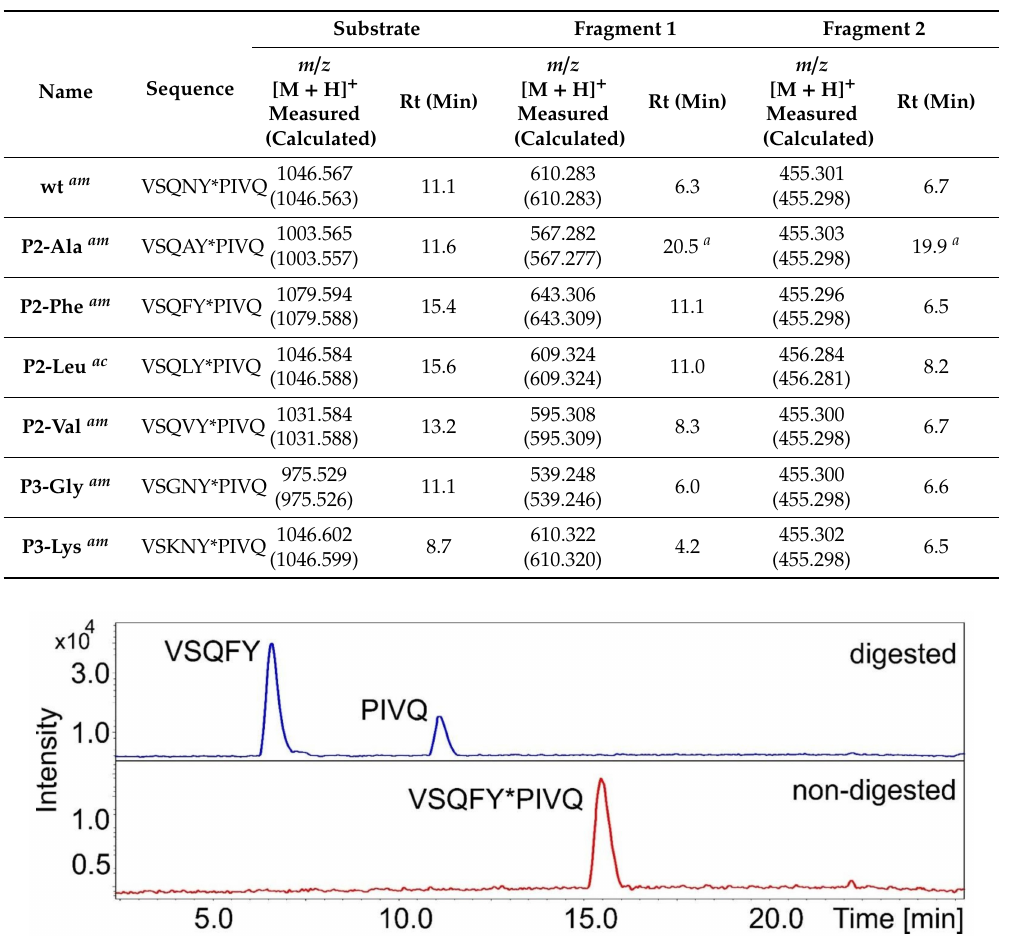
Table 3. Cleavage site identification in synthetic oligopeptide substrates by HPLC-MS. Oligopeptide